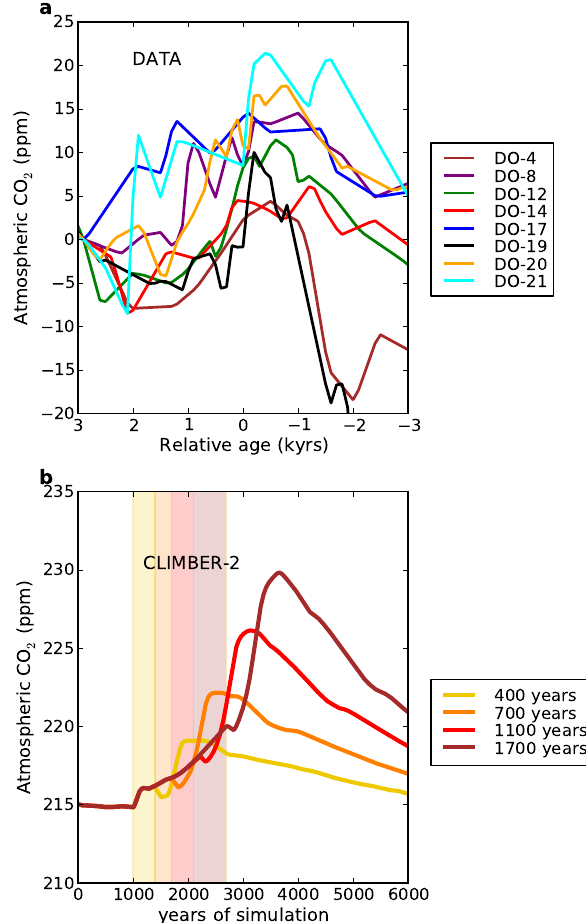
Fig. 20. (a) Atmospheric CO 2 anomalies during the abrupt warm- ings in Greenland (ppm) as in Ahn and Brook (2008), with respect to the initial value; (b) atmospheric CO 2 anomalies simulated by the CLIMBER-2 model with a fresh water flux into the North At- lantic following the “Duration” experiments (Fig. 1a), for the LGM conditions including the sinking of